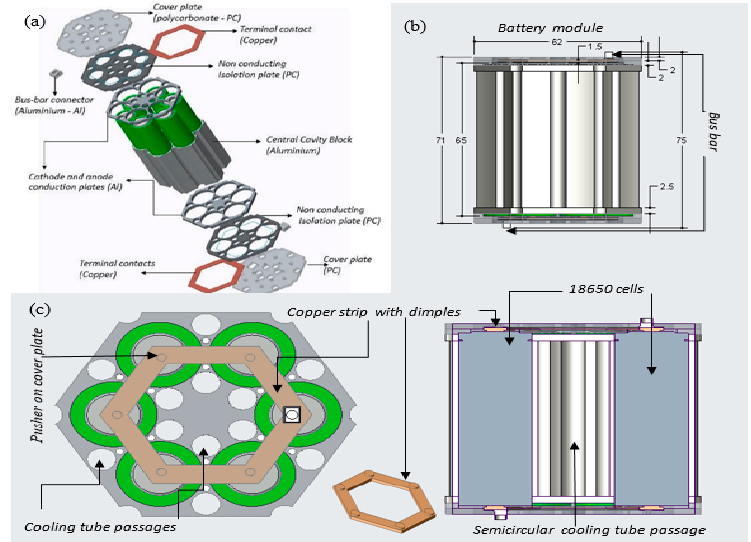
Figure 4. ( a ) Virtual prototype of the battery module with components and its materials. ( b ) Assembled view of the cell module. ( c ) Cross sectional view of cell module with semi-circular holes and a top view of the cell module with a copper strip (with dimples), bus bars, a cover plate, and cooling tube holes.